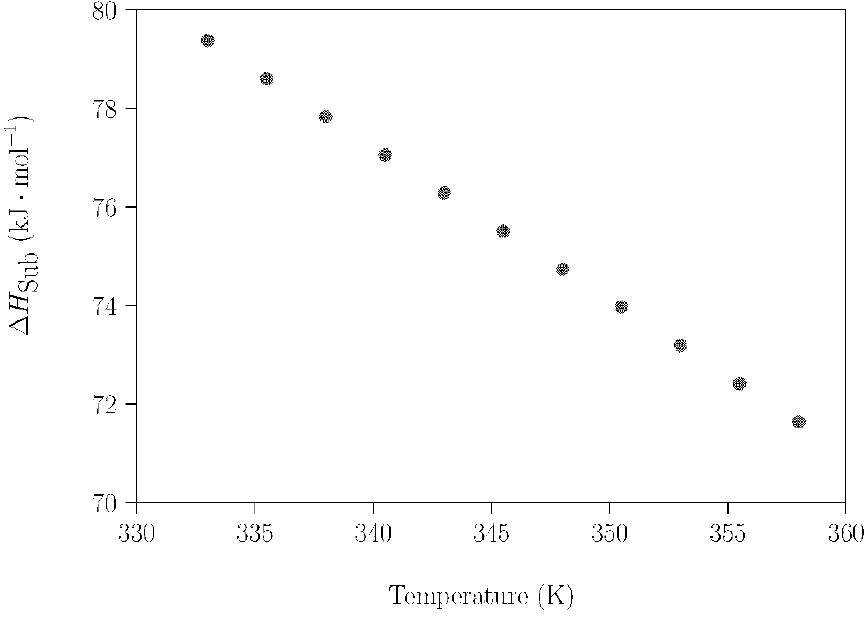
Figure 8. Δ H sub of NPG as a function of temperature (between 333 K and 358 K). Figure 8. ∆ H sub of NPG as a function of temperature (between 333 K and 358 K).